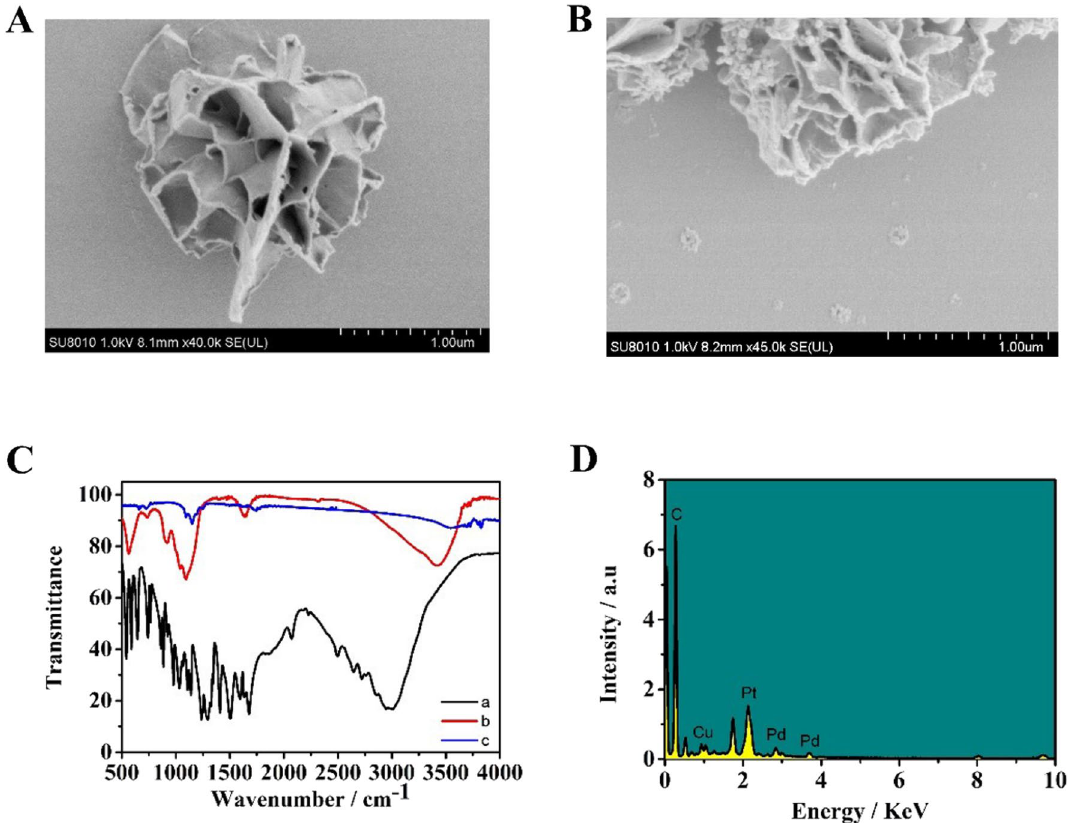
Figure 2. ( A ) jasmine-like Cu@L-Asp; ( B ) SEM images of Cu@L-Asp/Pd–Pt NPs; ( C ) The FT-IR spectra of (a) L-Asp; (b) Cu@L-Asp; (c) Cu@L-Asp/Pd–Pt NPs ( D ) The EDS spectra of Cu@L-Asp/Pd–Pt NPs.